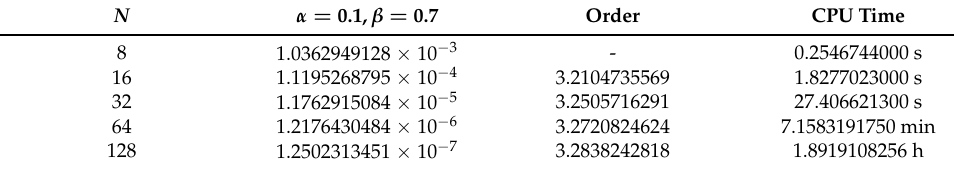
Table 2. Maximum errors, decay rate and CPU time with M = 2 N . N α = 0.1, β = 0.7